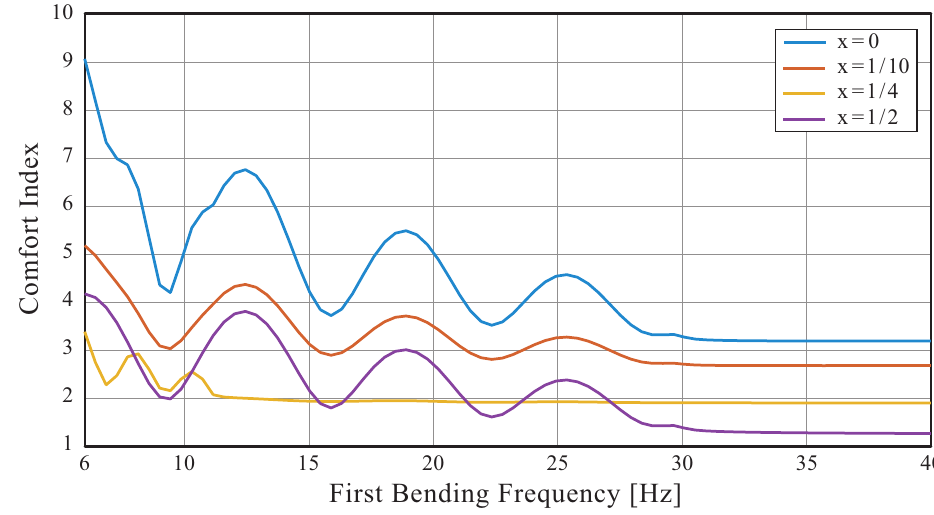
Figure 9. Comfort index at four locations on the beam versus f 3 with outstretched upper